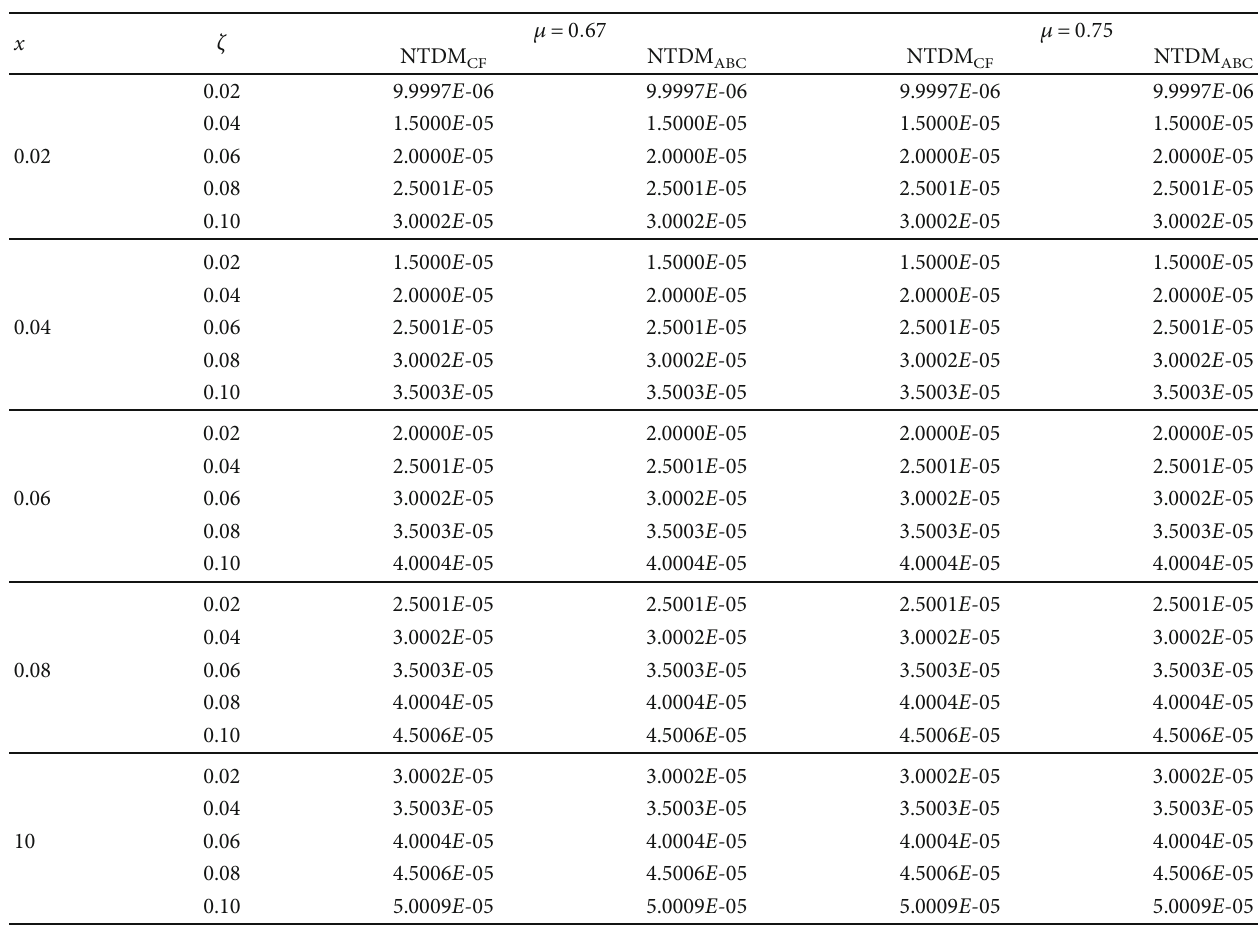
Table 4: Approximate solutions of NTDM x ζ